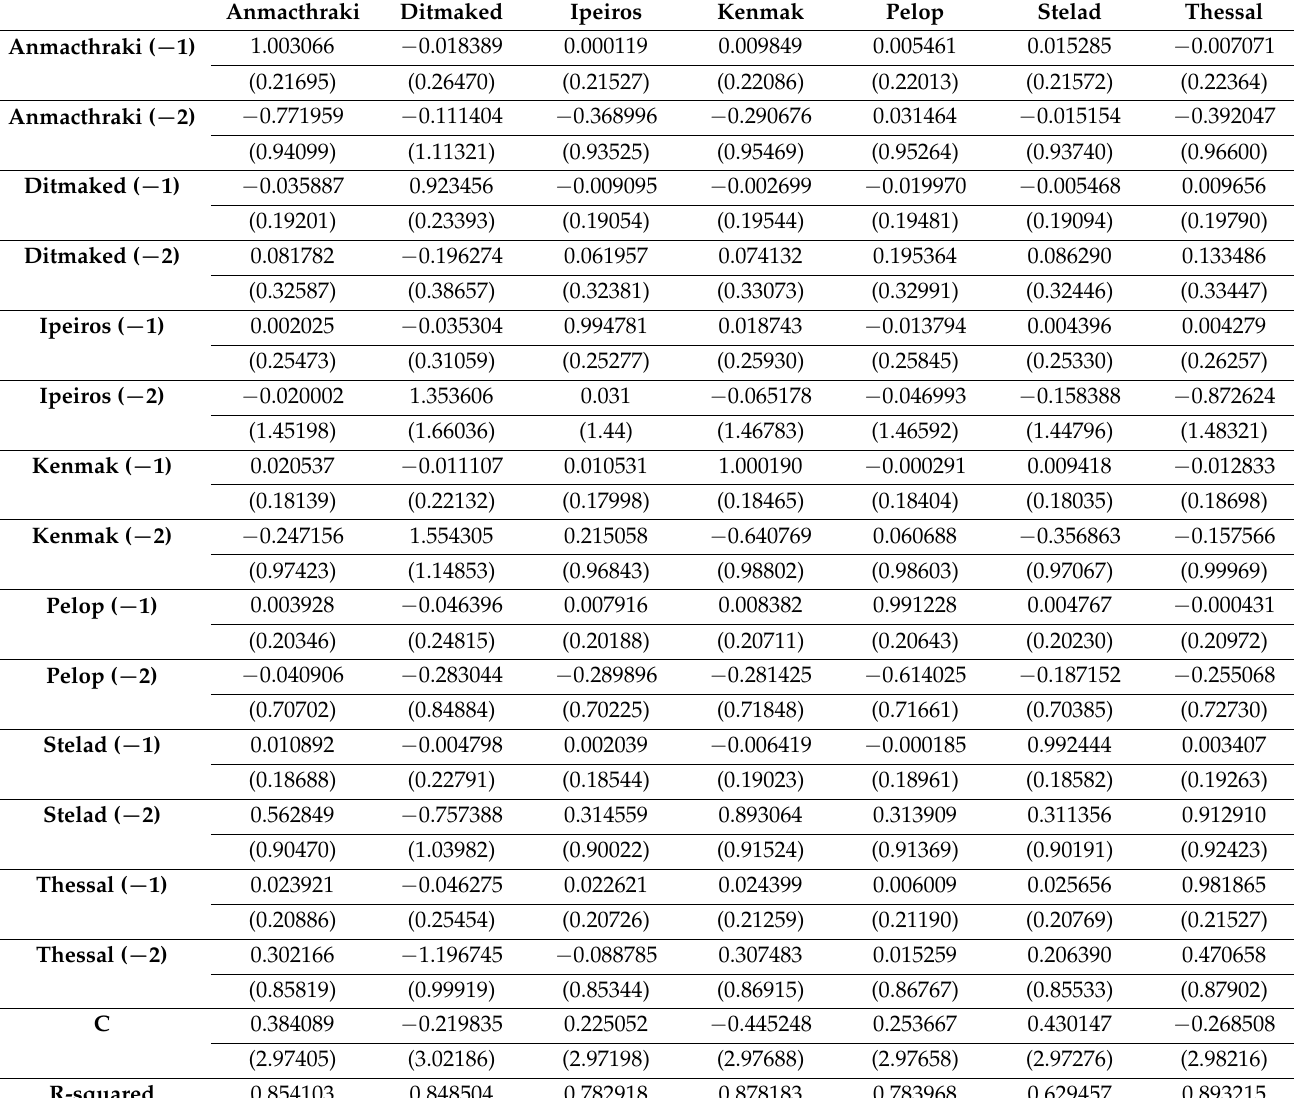
Table 2. Short and long run